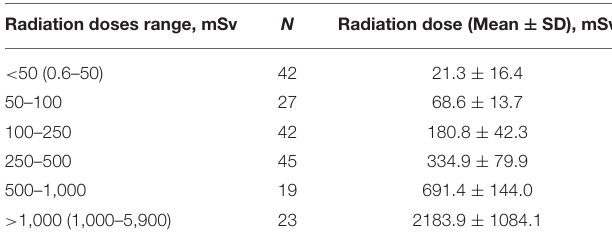
TABLE 1 | Distribution of cleanup workers of the Chornobyl catastrophe by radiation doses of external exposure. Radiation doses range,